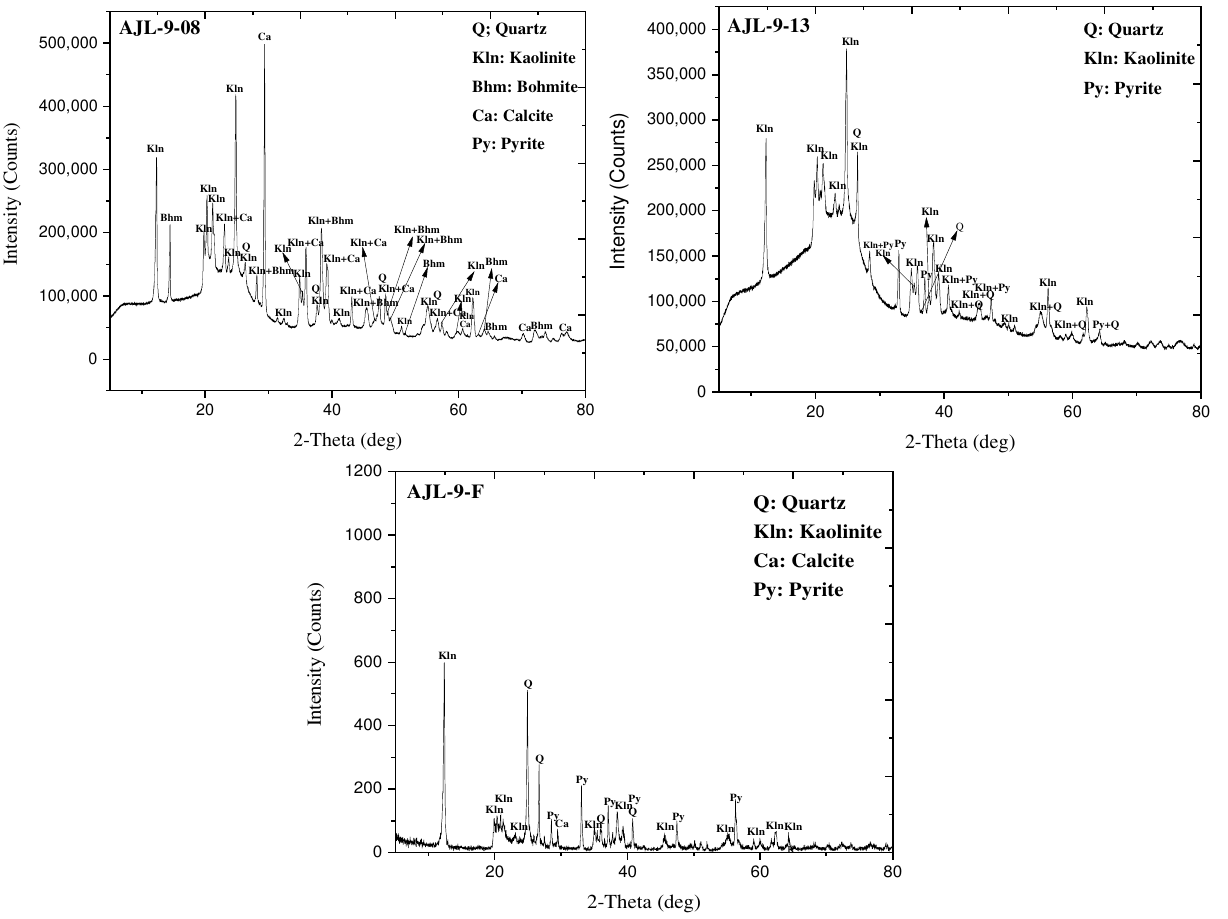
Minerals 2022 , 12 , x FOR PEER REVIEW Figure 3. The XRD patterns of the mineral components in coal from the Anjialing coal seam 9. Under the reflected light of oil immersion, the clay minerals in the coal samples ap- peared brownish. Kaolinite was observed under reflected light and mainly occurred in the infillings of cell cavities in fusinite (Figure 4A,C). The carbonate minerals in the coal were mainly dominated by calcite. Calcite was commonly observed under the microscope in the thin sections of coal from the Anjialing coal seam 9. It could be seen that the calcite in the coal formed directionally along fractured surfaces as infillings in the coal (Figure 4B). The sulfide minerals in the coal were mainly pyrite. The formation of pyrite is af- fected by space and environment and it has different forms, some of which fill cell cavities and fissures. The pyrite crystals in our samples were brass-colored (bright yellow) under reflected light (Figure 4D).